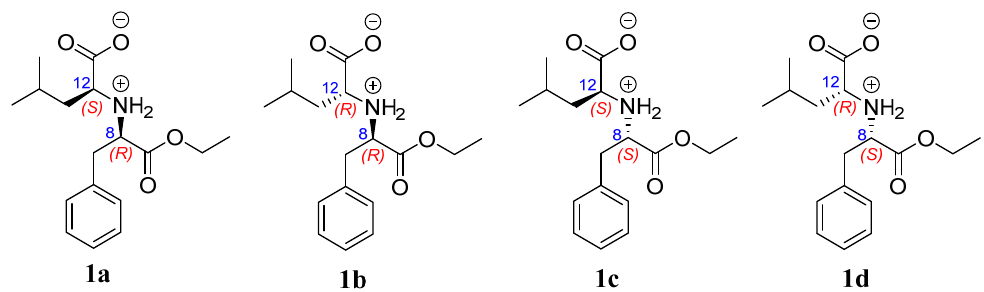
Figure 3. Four possible relative configurations of compound 1 .